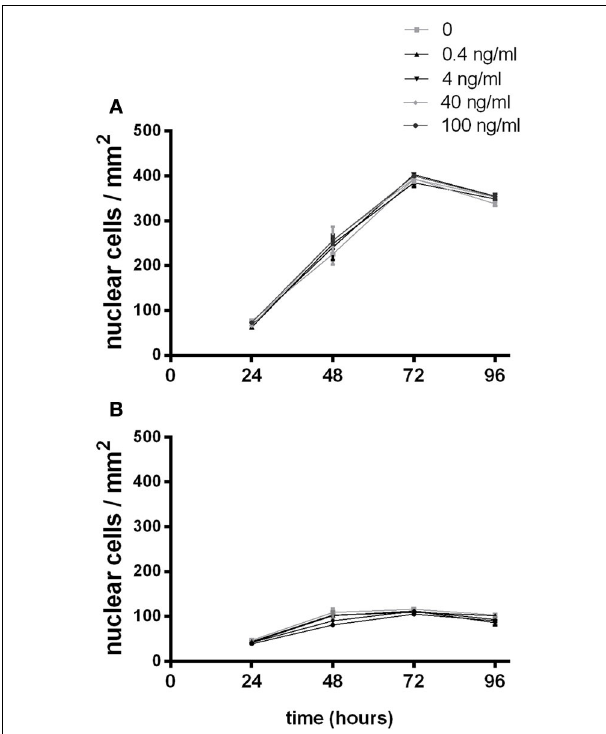
FIGURE 5 | The effects of G-CSF treatment on C2C12 myoblast proliferation. Proliferating C2C12myoblasts incubated in the presence of the indicated concentration of G-CSF under (A) normal growth media containing 10% fetal bovine serum or (B) serum depleted growth media containing 2% BSA. Data represents the mean ± SEM taken from a minimum of 10 images per sample ( n =